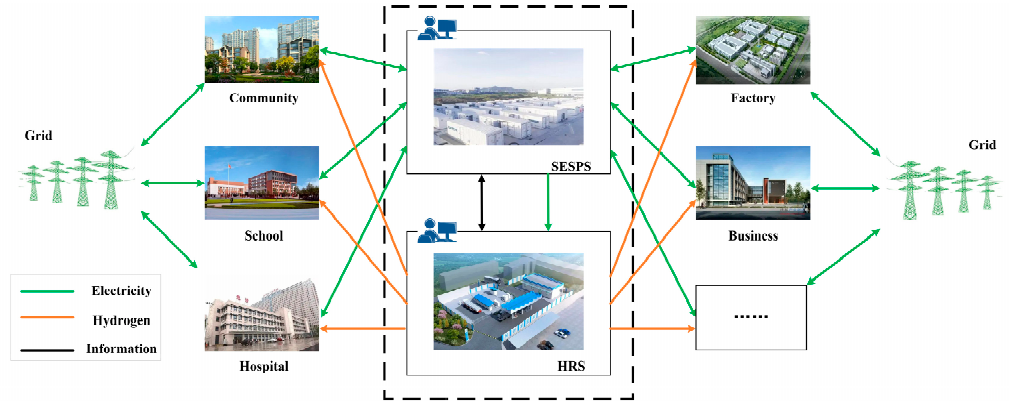
Figure 2. Cooperation diagram of SESPS and HRS.